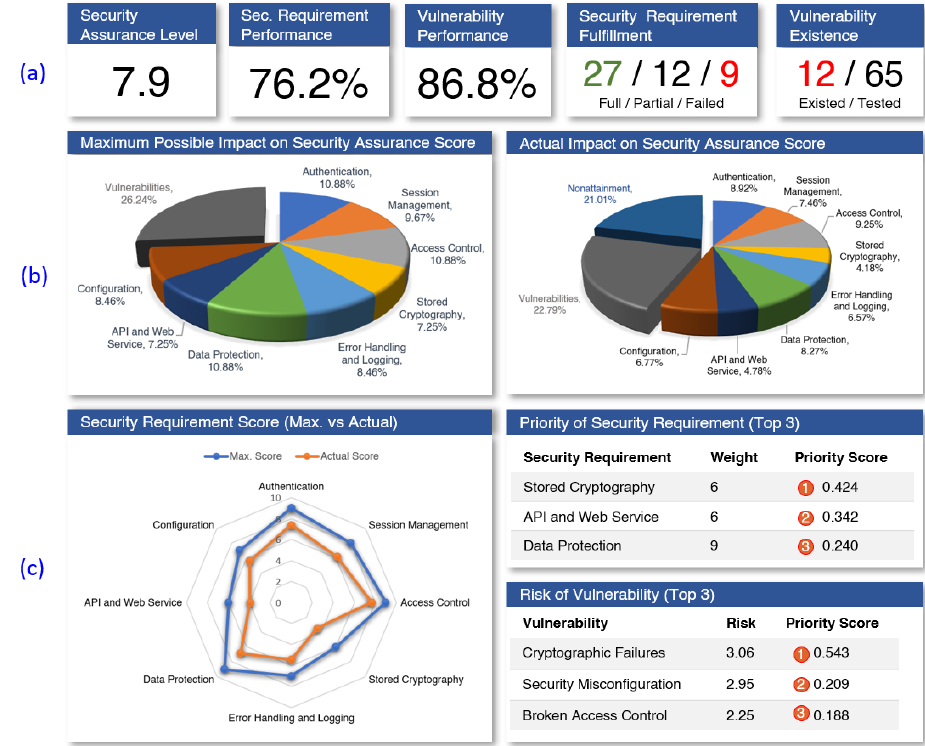
Figure 6. Security assurance analytics dashboard—single system view.